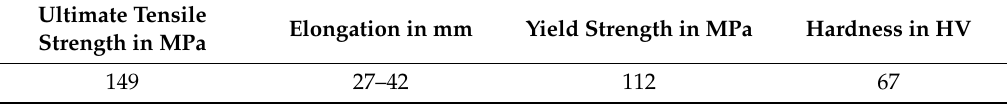
Table 2. Mechanical properties of the base SSM 6063 aluminum alloy used in this experiment [22].